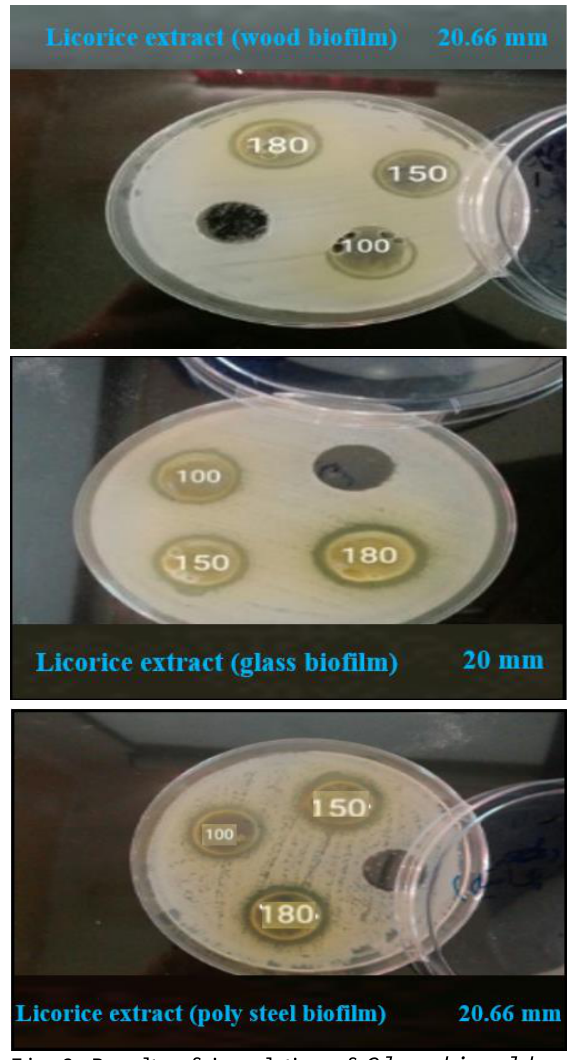
Fig. 2. Results of inoculation of Glycyrrhiza glabra extract in Pseudomonas aeruginosa bacterial biofilm on wood, glass, and polysteel surfaces